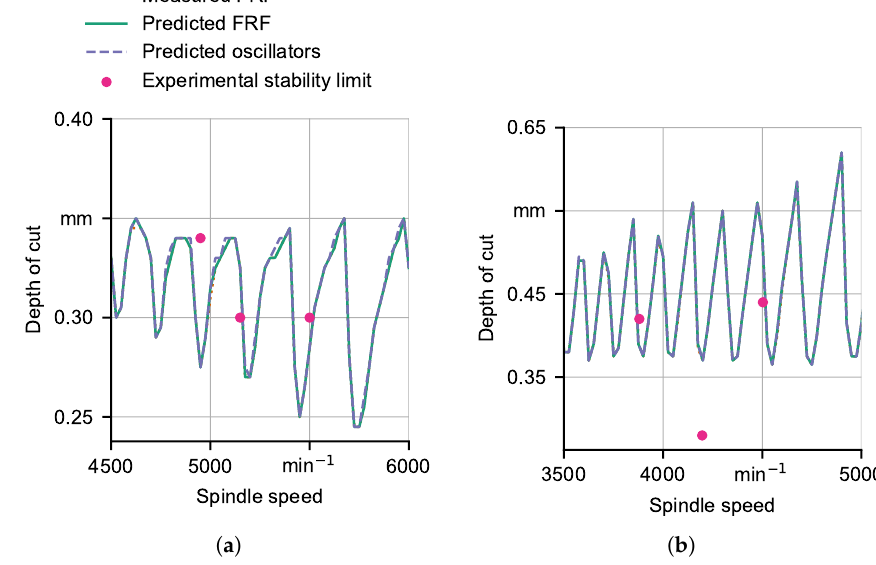
Figure 8. SLDs calculated using compliance models acquired by the different presented approaches for an inclination angle of ( a ) B = − 20 ◦ and ( b ) B = − 30 ◦